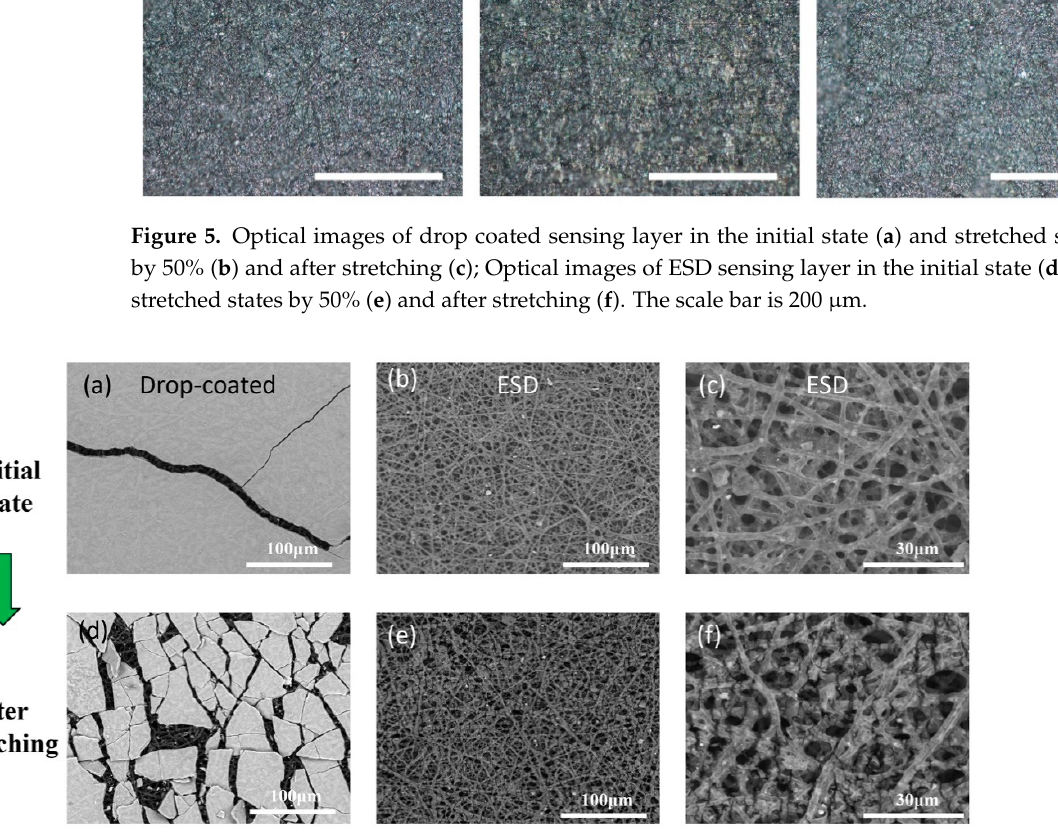
Figure 6. SEM images of drop coated sensing layer in the initial state ( a ) and after stretching ( d ); SEM images of ESD sensing layer in the initial state ( b,c ) and after stretching ( e,f ).